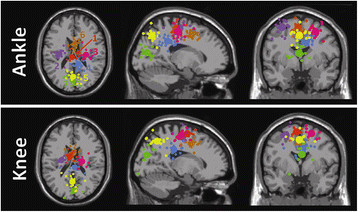
Clusters of electrocortical source equivalent current dipoles localized to the (1: orange) supplementary motor area, (2: purple) left dorsal premotor area, (3: magenta) right dorsal premotor area, (4: blue) posterior cingulate, (5: yellow) posterior parietal, (6: brown) anterior cingulate, and (7: green) visual cortex. Two dipole models are shown; (top) the model best fitting the EEG signals during ankle exercises and (bottom) knee exercises. Small spheres indicate dipole locations for single electrocortical sources for single subjects; larger spheres indicate geometric cluster centroids